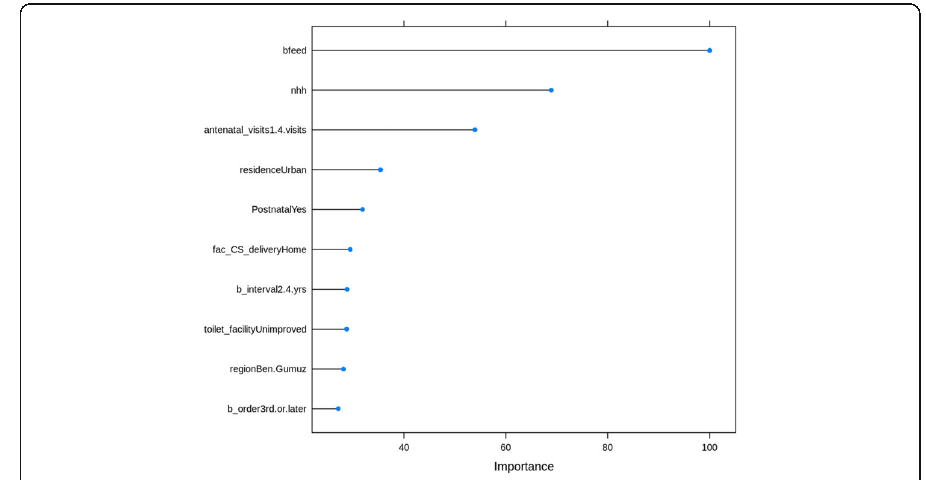
Fig. 5 Variable importance measures for K-nearest neighbor